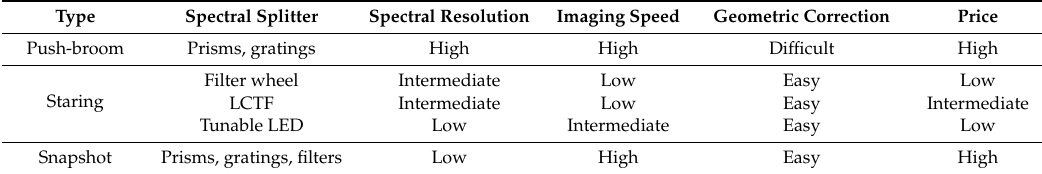
Table 4. Comparison of di ff erent architectures of the underwater spectral imaging system. LCTF: liquid crystal tunable